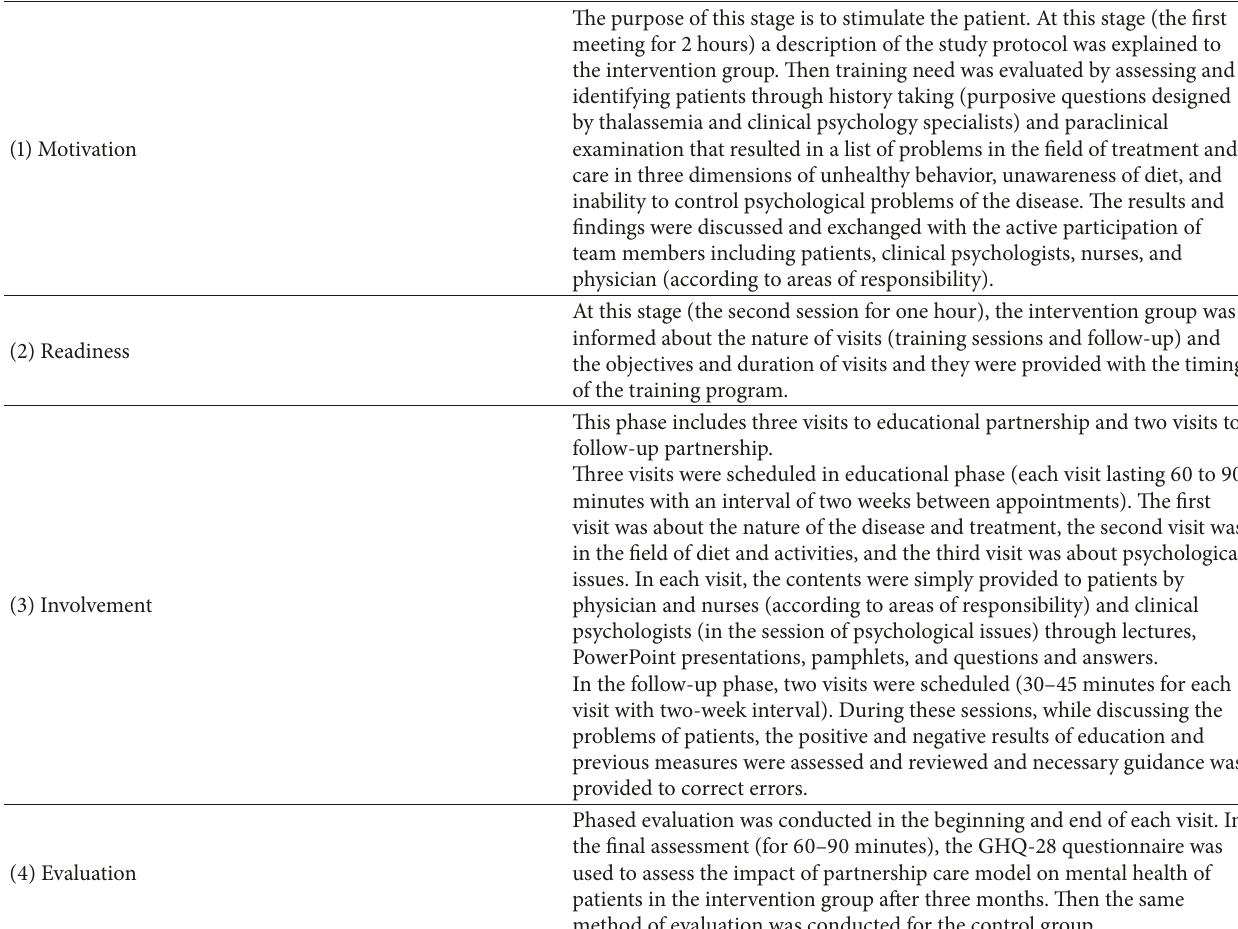
Table 1: The order and content of the training sessions based partnership care